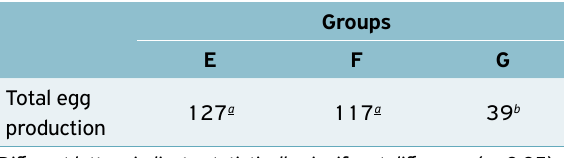
Table 4. Cumulative number of eggs laid by adult hens vaccinated with three doses in experiment 2, from 17 to 24 weeks-of-age (28